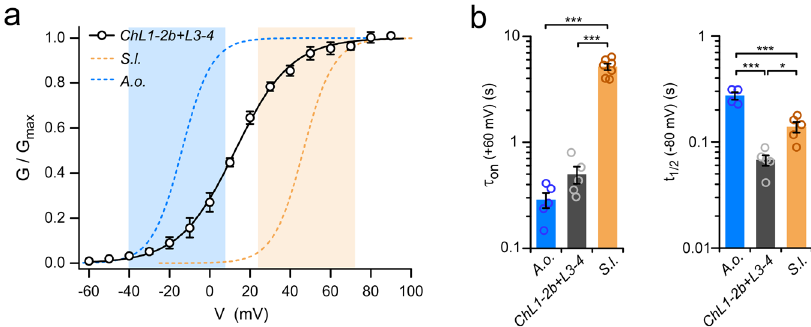
Fig. 6 Activation properties of Sl/AoHv1 chimeric channel with swaps in S1 – S2 and at S3 – S4 loops. a G – V curve of ChL1-2b + L3-4 chimera compared to parent channels SlHv1 and AoHv1 (pH i = pH o = 6.0). Conductance of chimera starts increasing within the voltage range of AoHv1 activation (blue-shaded area) and reaches maximum within the voltage range of SlHv1 activation (orange-shaded area). G – V parameters derived from Boltzmann fi t of the data are: V = 12.7 ± 1.7 mV, slope = 13.9 ± 1.3 mV ( n = 5). b Time constant of activation ( τ 1/2 compared to parent channels SlHv1 and AoHv1. τ on was measured at 60 mV and t 1/2 was measured at − 80 mV. Bars are mean values from 4 to 5 independent measurements ± SEM. A one-way ANOVA multiple comparison test with Tukey ’ s post hoc correction was used for statistical analysis: * p < 0.05, *** p <